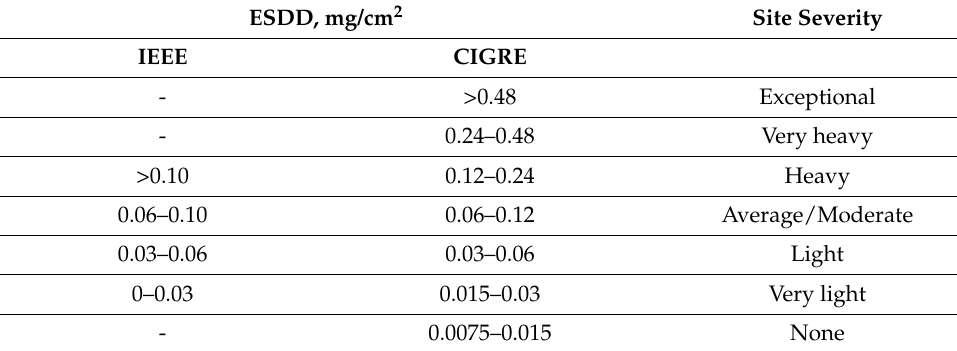
Table 2. The CIGRE and IEEE standards for contamination level classification